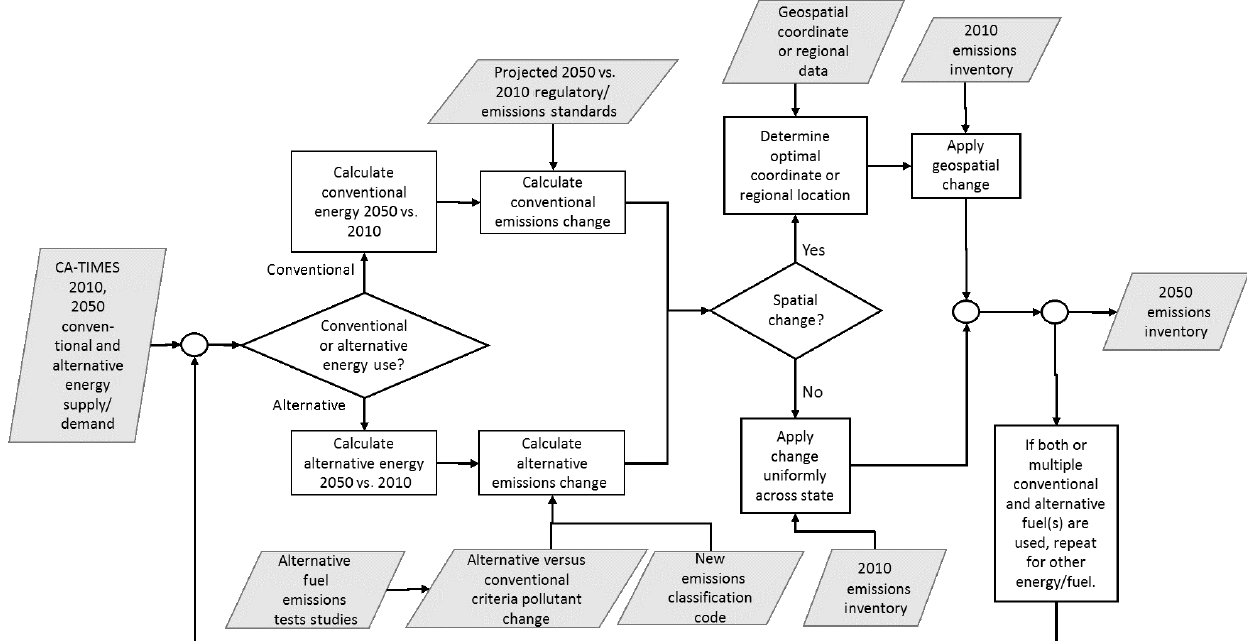
Figure 2. Process diagram of emissions inventory generation for each sector or mode.